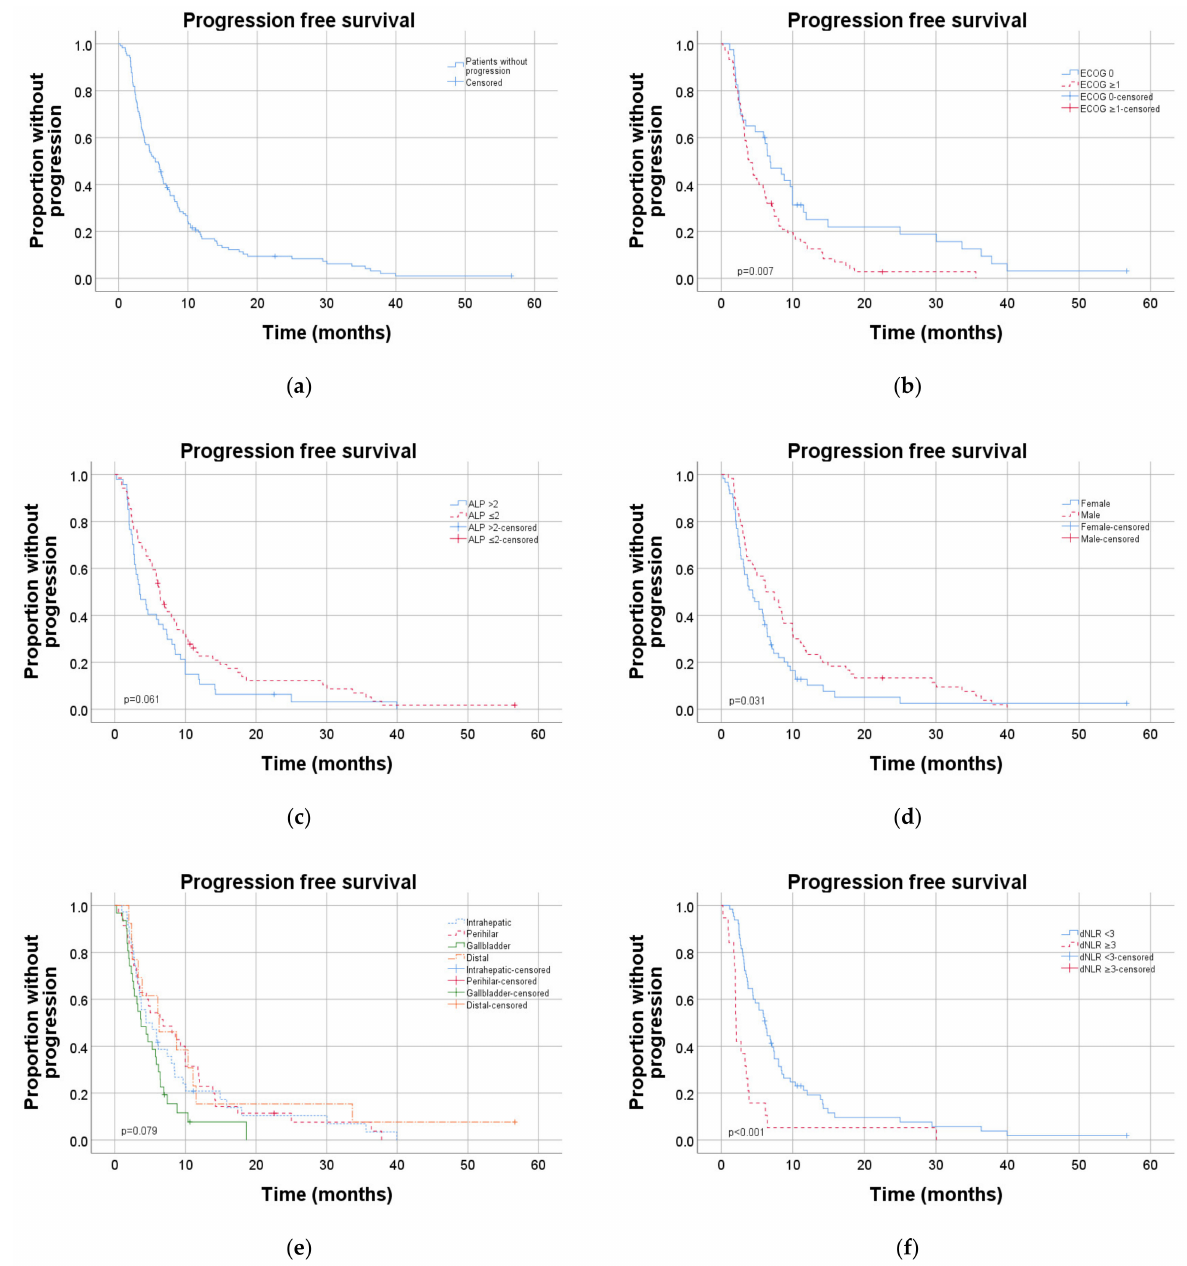
Figure 3. Kaplan–Meier diagrams showing progression-free survival for different subgroups: ( a ) total cohort, ( b ) performance status, ( c ) ALP at baseline, ( d ) gender, ( e ) diagnosis and ( f ) dNLR at baseline. dNLR: derived neutrophil/lymphocyte